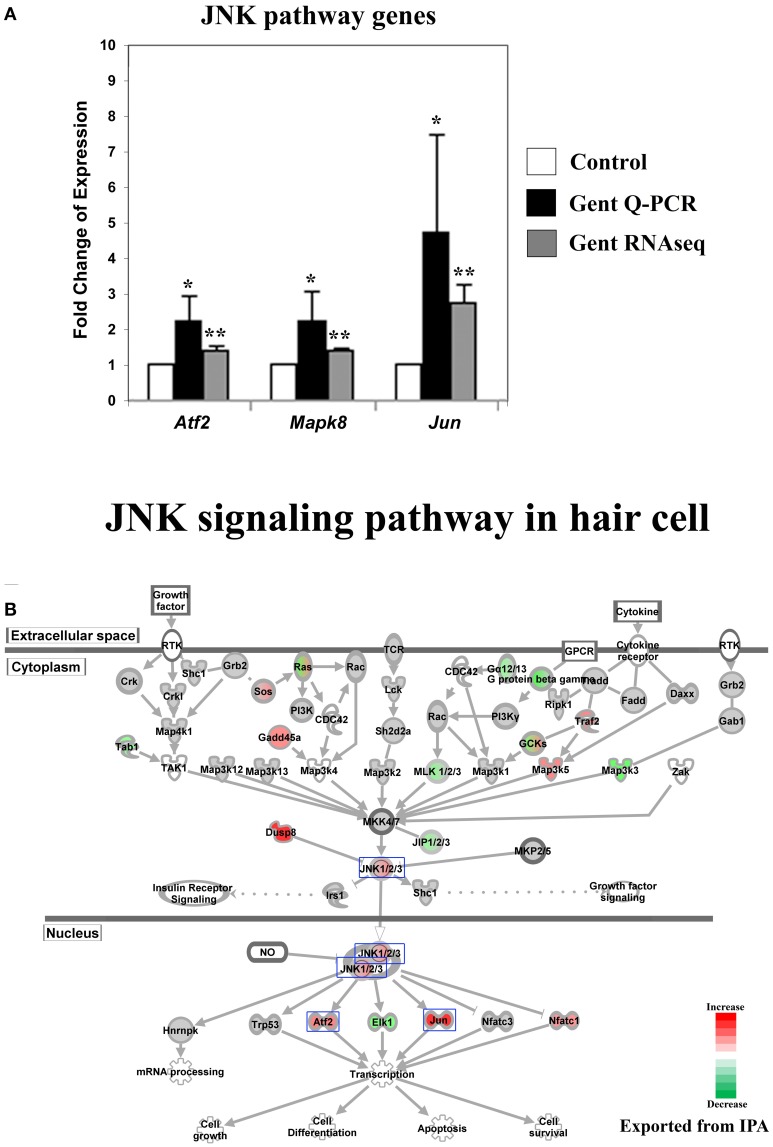
Gentamicin-induced changes in expression of genes in the Jun-kinase (JNK) pathway. (A) Q-PCR results validating increased messenger RNA levels in hair cells after gentamicin treatment. Error bar, standard deviation: *p < 0.05; **p < 0.01. (B) The JNK signaling pathway with color-coded expression changes indicating significant transcriptional response to gentamicin. Only genes with significant expression changes are colored. Red, increased expression; green, decreased expression relative to control; half red-half green, indicates nodes with multiple genes with some genes upregulated and some genes downregulated. Genes validated and discussed in the text are boxed in the corresponding protein pathway diagrams.